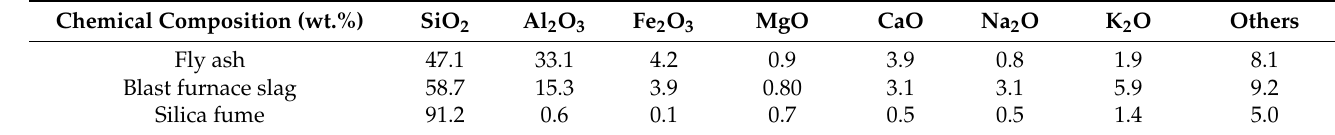
Table 1. Chemical composition of fly ash, blast furnace slag, and silica fumes.